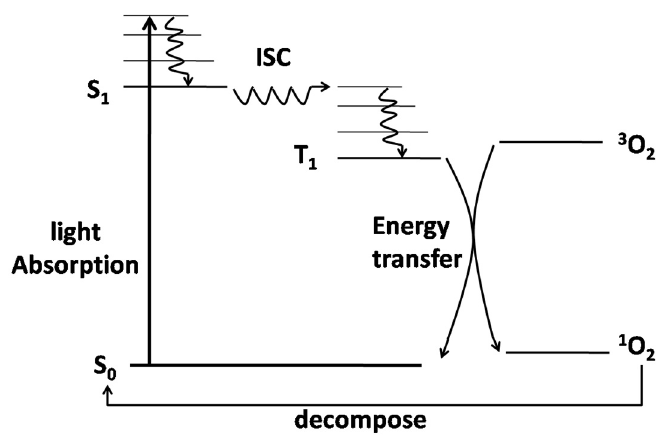
Figure 2. Self-sensitized photolysis by the photosensitized excitation of oxygen in its ground triplet state ( 3 O 2 ) to its lowest singlet excited state ( 1 O 2 ) (S 0 : photosensitizer ground state; S 1 : singlet excited state; ISC: intersystem crossing; T 1 : triplet state). Reproduced with permission from Martin et al. , J. Photochem. Photobiol . [63]; published by Elsevier, 2017.